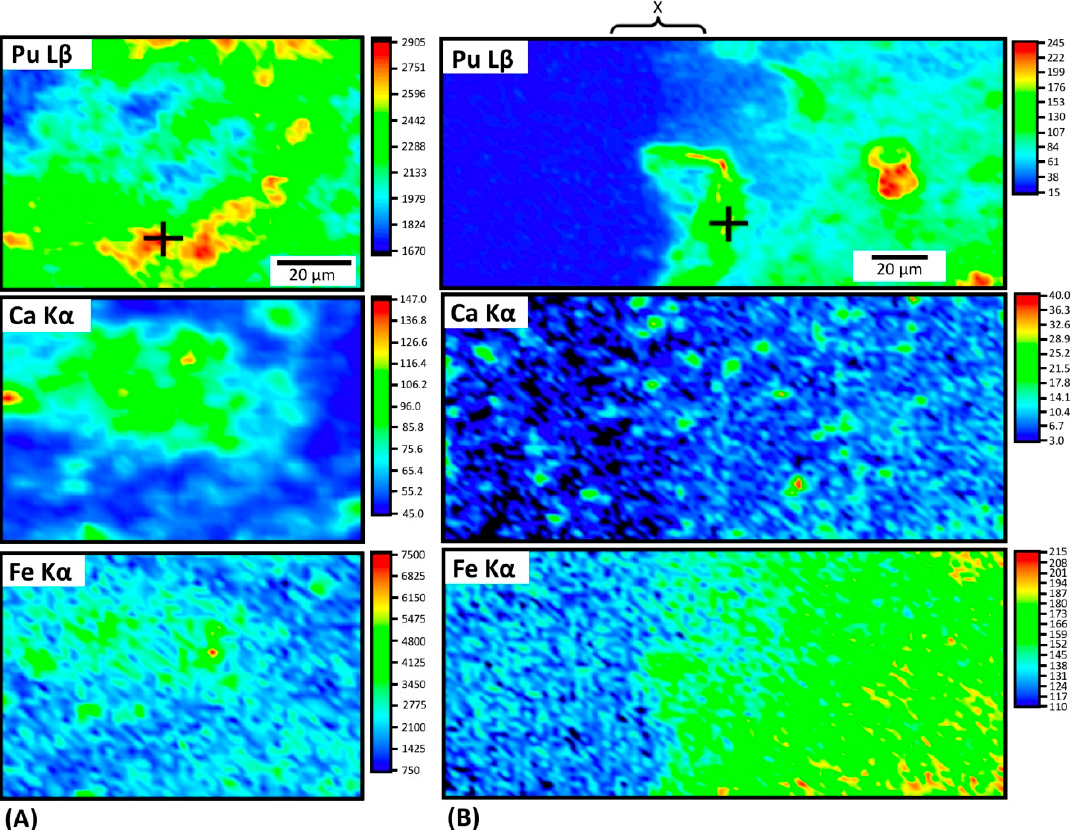
Figure 5. µ-XRF maps showing Pu, Ca, and Fe across two cement samples. ( A ) µ-XRF maps of Pu, Ca, and Fe from the unaltered core of sample 4 (unleached, long cure). XAS spectra were collected from the area marked with cross hairs. ( B ) XRF maps from sample 3 (leached, long cure) showing the interface of the leached zone into the unleached area (interface marked with an X). XAS data were collected from the spot marked with cross hairs on the boundary with the leached horizon. This probed Pu chemistry at the front of the advancing dissolution zone where the Pu- and cement- elements (Ca, Fe) were